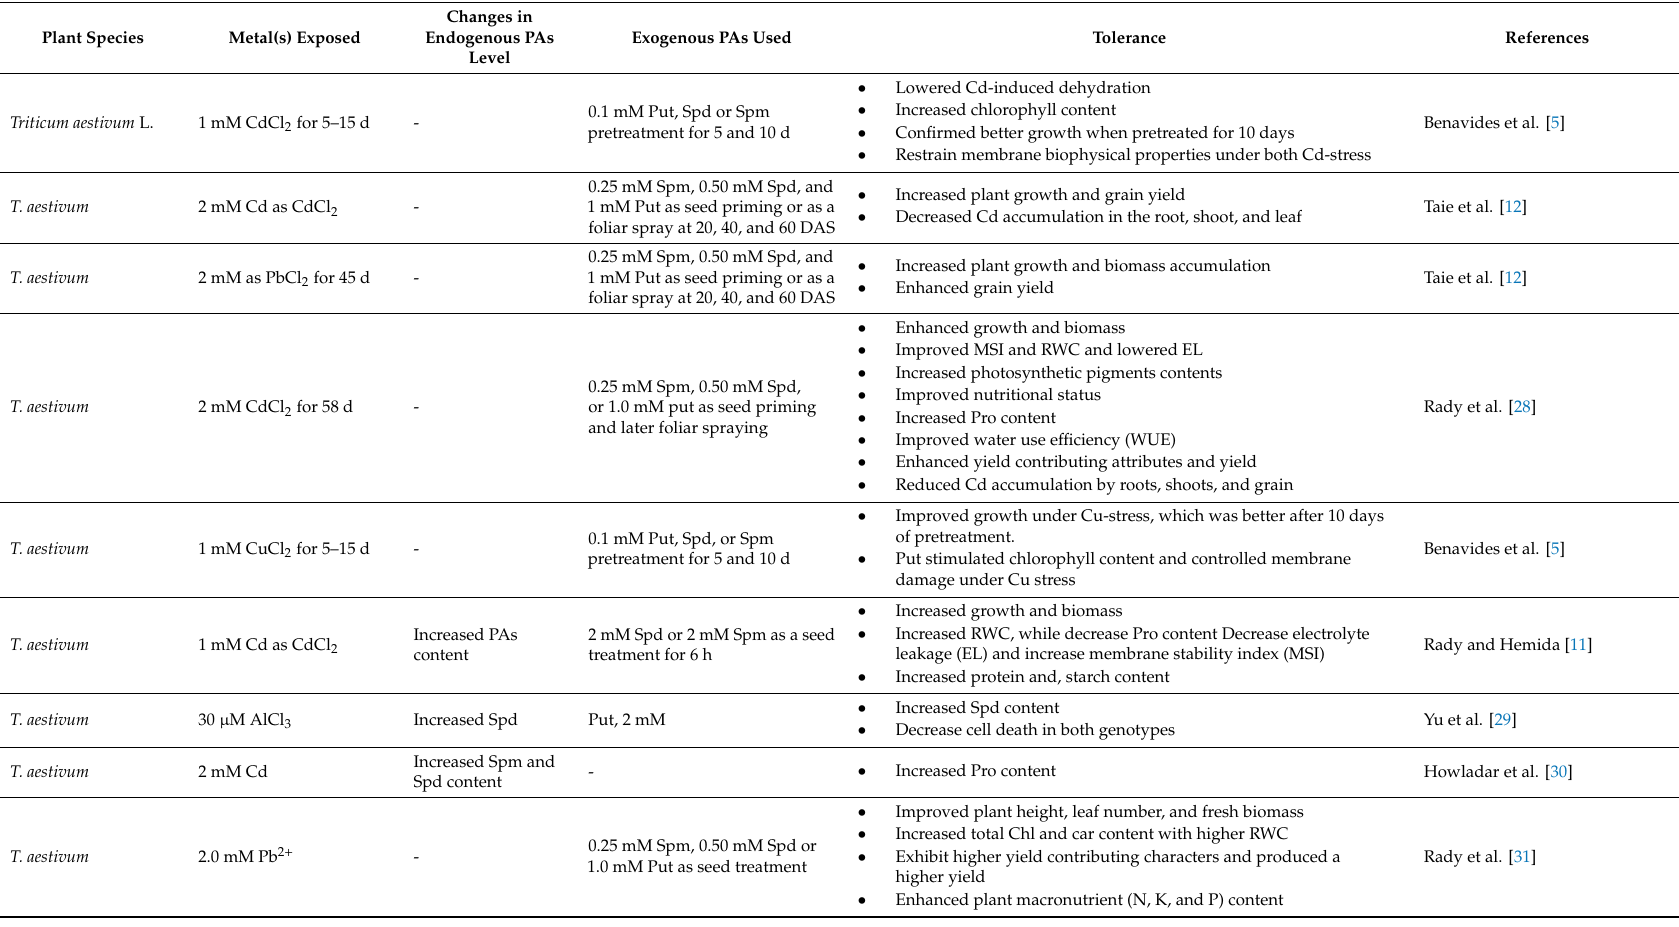
Table 1. Polyamine-induced metal / metalloid(s) tolerance in di ff erent plant